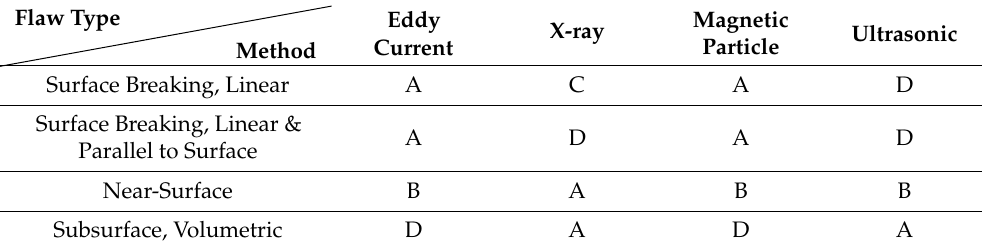
Table 1. Ratings of the various detection methods by Foerster GmbH. Flaw